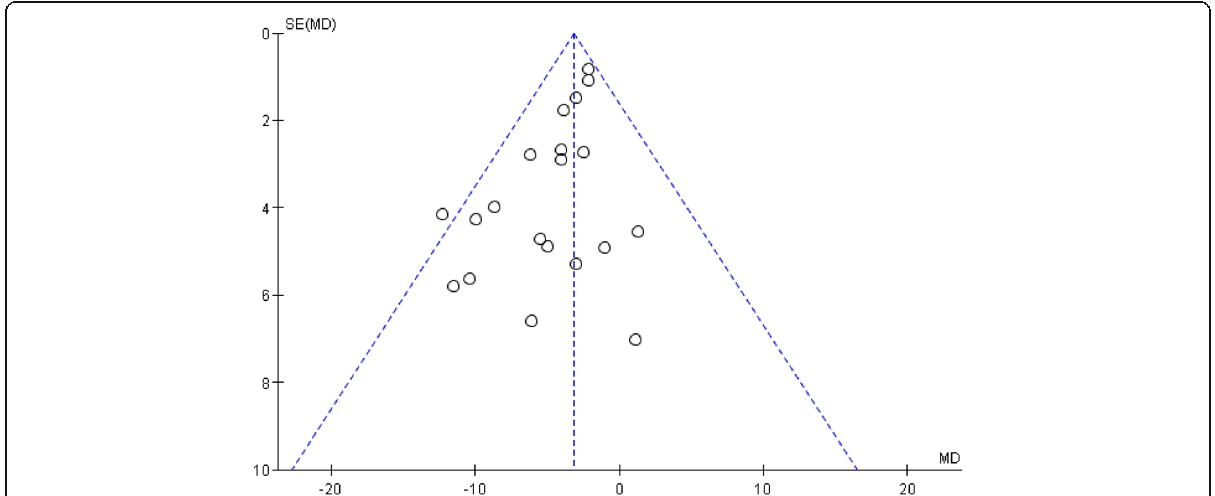
Fig. 6 Funnel plot, using data from 20 trials of therapeutic effects of the forest environment on systolic blood pressure. SE, standard error; MD, mean